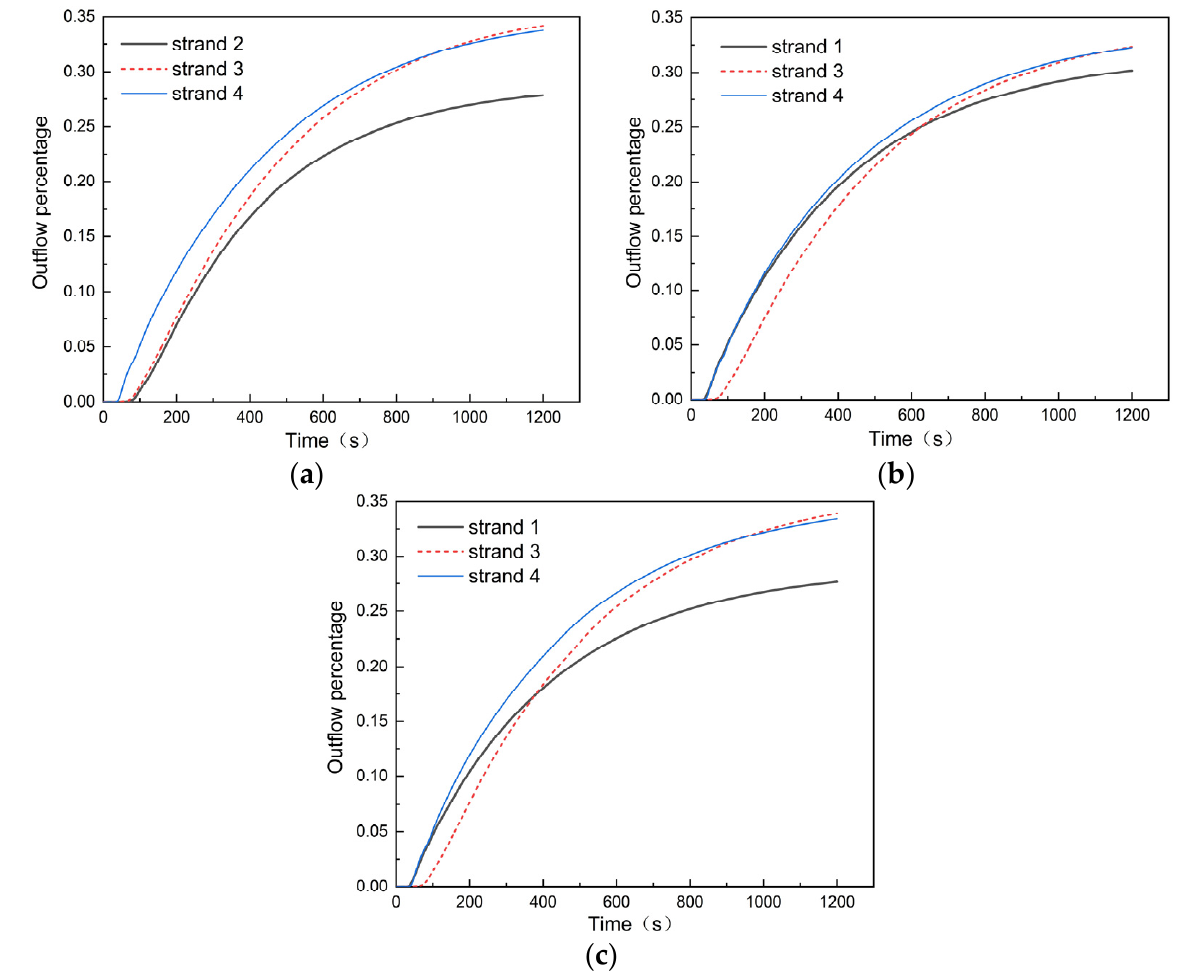
Figure 27. Outflow percentage curve of the u-shaped weir tundish with non-uniform increasing casting flow rate under strand 2 blockage condition: ( a ) 1.25 q, 1.375 q, 1.375 q, ( b ) 1.2 q, 1.4 q, 1.4 q, ( c ) 1.1 q, 1.45, 1.45 q.